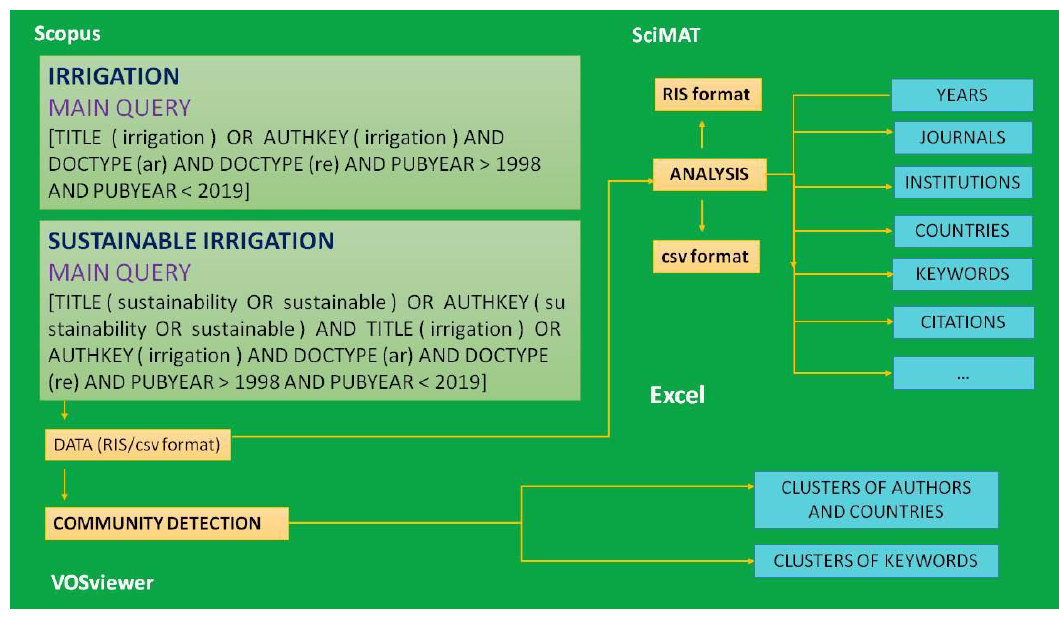
Figure 1. Outline of the methodological development of this study.